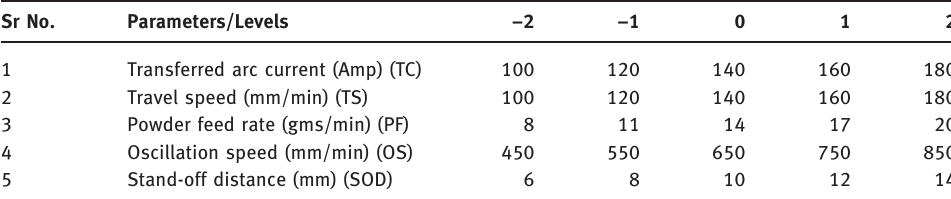
Table 2: Process parameters, their working limits and levels. Sr